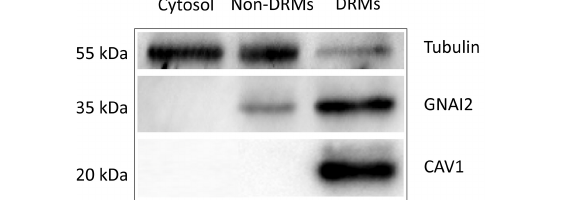
FIGURE2 Western blot analysis of Tubulin, GNAI2, and CAV1 proteins in cytoplasmic (Cytosol.), non-detergent-resistant membrane (Non-DRMs), and DRM preparations collected from ARPE19 cell homogenates during successive detergent extraction. Five micrograms of proteins from each preparation were loaded on SDS-PAGE, separated, electro-transferred, and immunoblotted with antibodies against the indicated proteins. The micrographs presented were representative of three independent